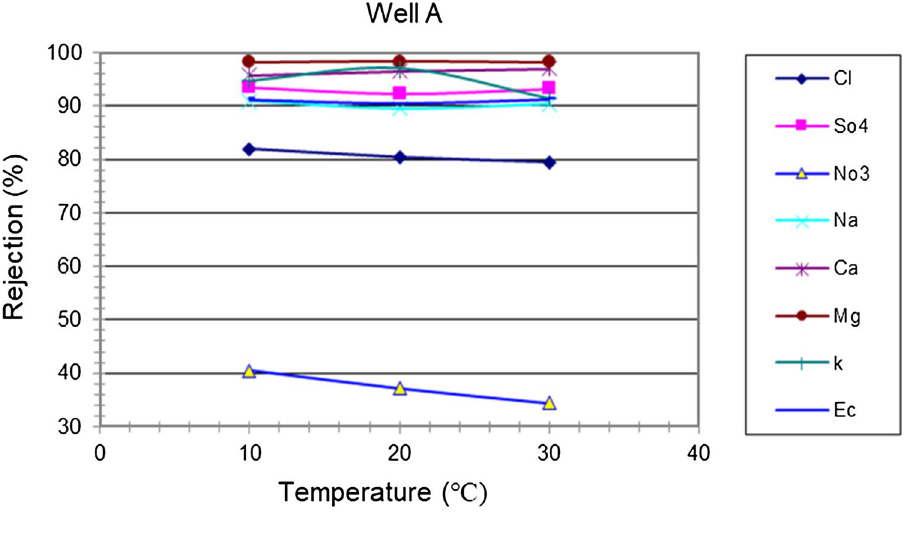
Fig. 8 Rejection rate of ions versus temperature (pressure: 4